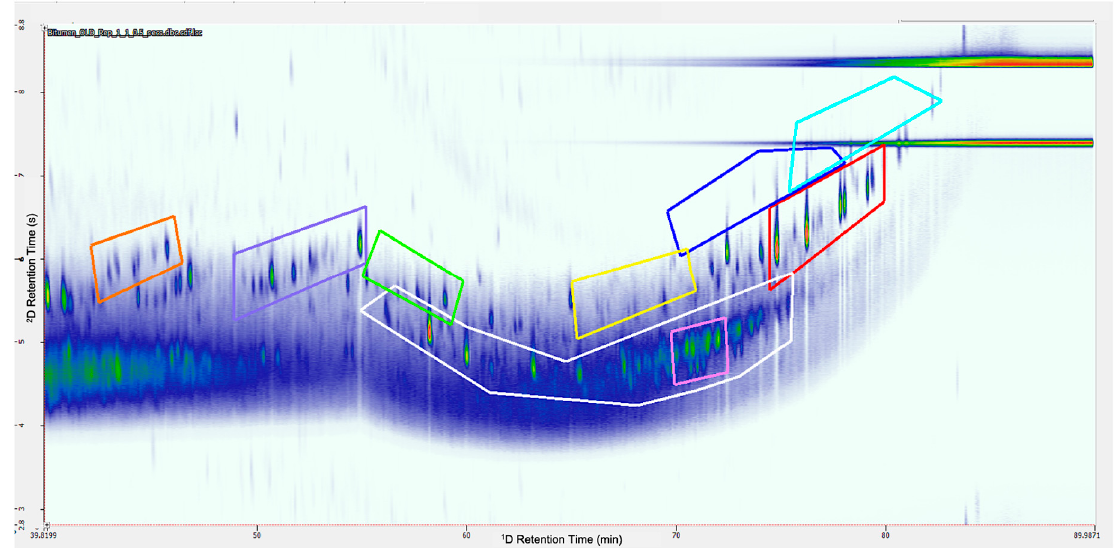
Figure 4. Biomarker analysis of bitumen oil sands extracted with cyclohexane. The colored boxes correspond to various biomarker groups: C 2 & C 3 alkylated steranes ( orange ), C 4 & C 5 alkylated steranes ( purple ), C 6 alkylated steranes ( green ), cyclic terpanes ( white ), diasteranes ( pink ), monoaromatic steranes ( yellow ), triaromatic steranes ( blue ), methyl hopanes ( red ) and methyl steranes ( teal ).